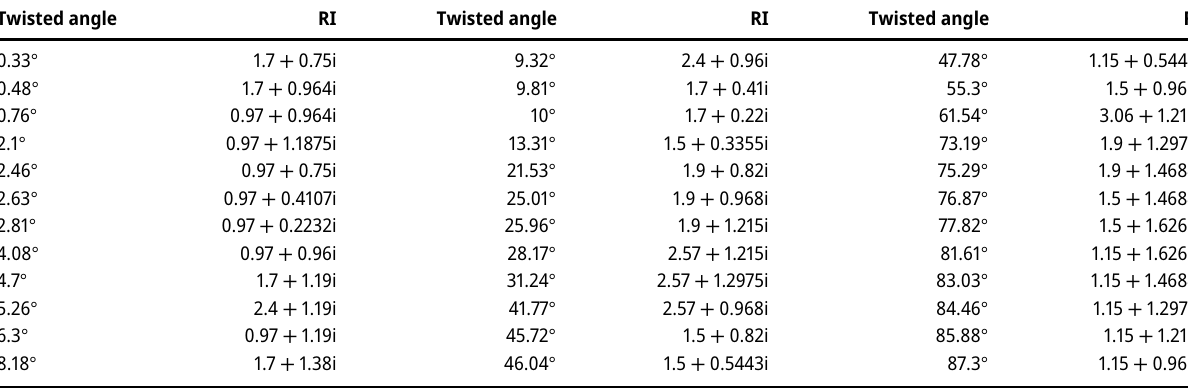
Table 1: optical RI of TBG system with various twisted angles ( 𝛼 ) under the excitation of 632.8 nm. Twisted angle RI Twisted angle RI Twisted angle RI 0.33